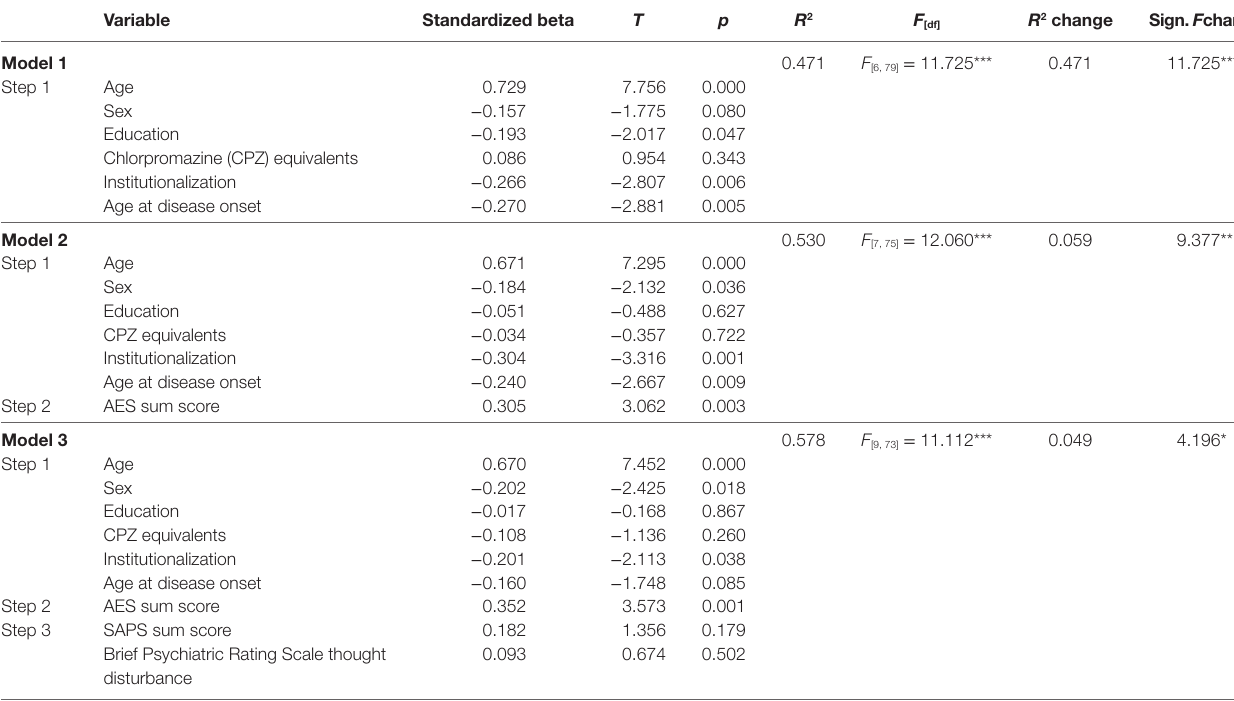
Table 4 | Results of regression analyses (patients only). Variable